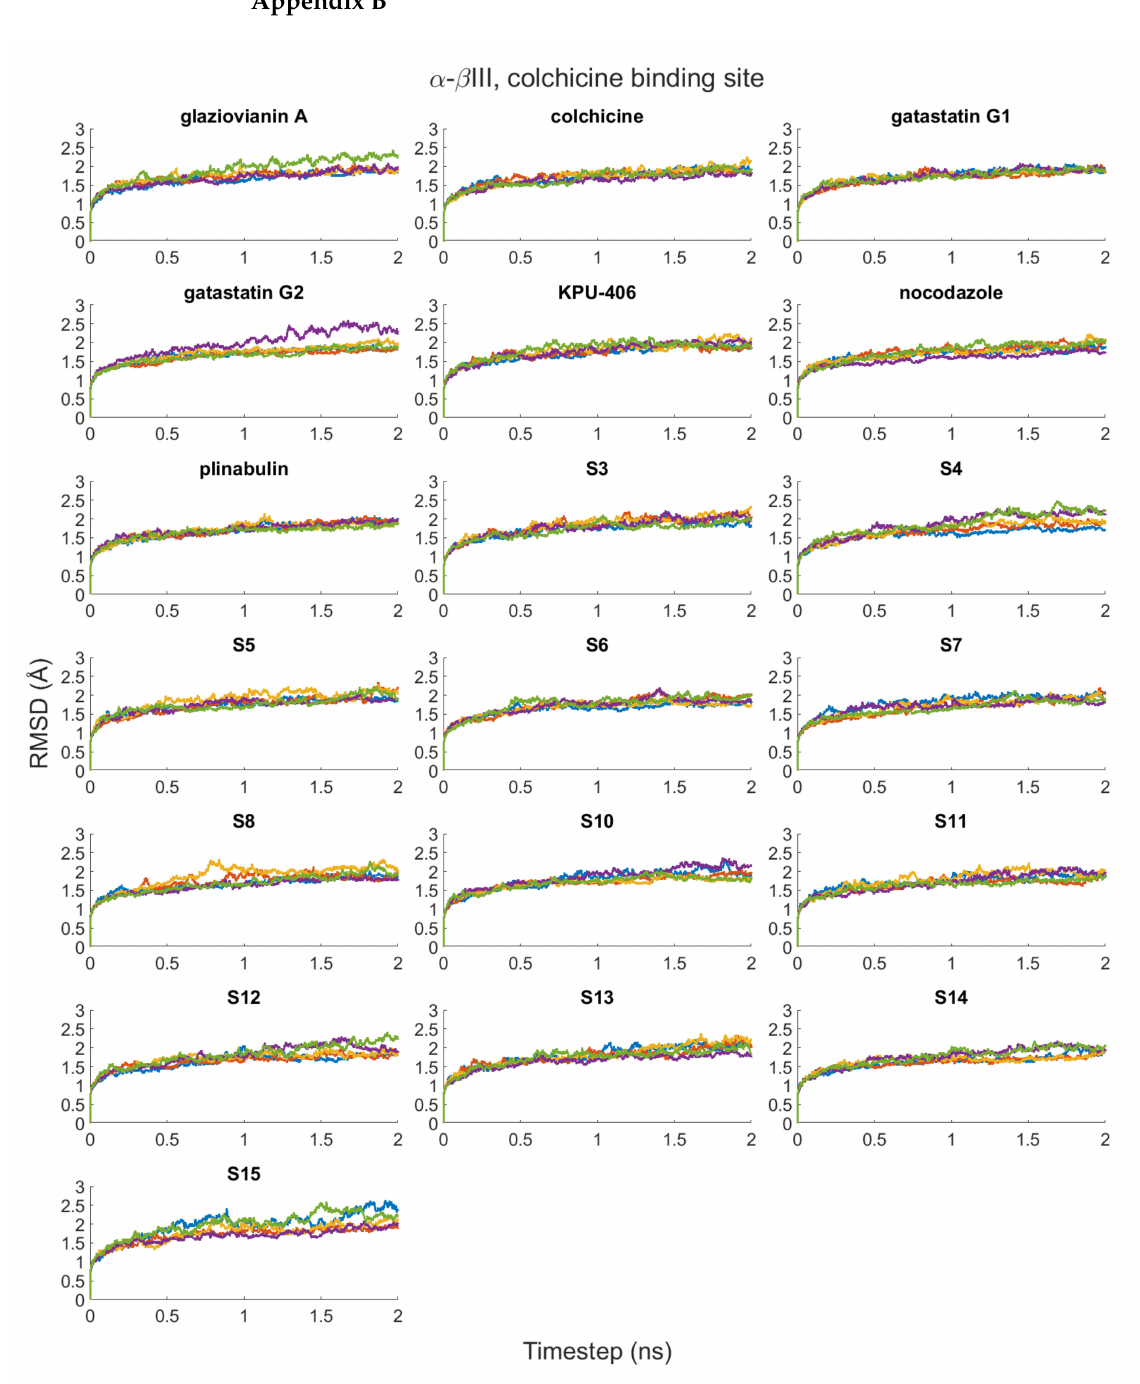
Figure A3. RMSD plots of the MD simulations of structures of α - β III in complex with the investigated